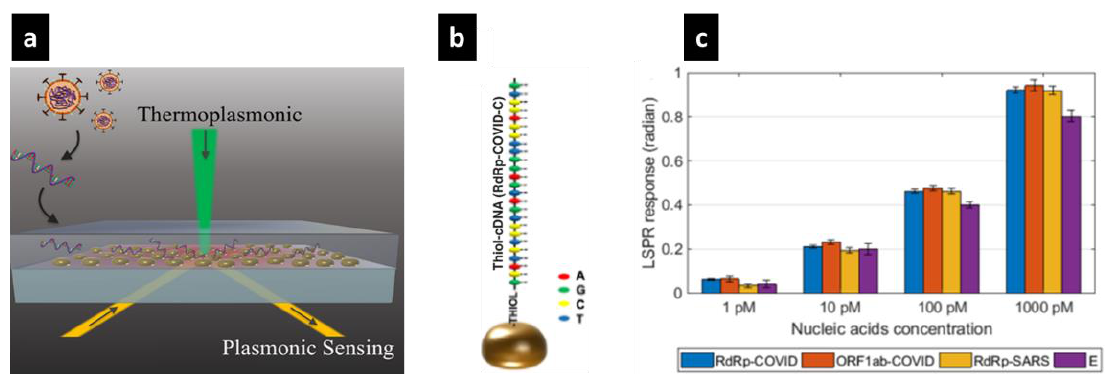
Figure 11. ( a ) Schematic diagram of a plasmonic biosensor. ( b ) Schematic illustration of surface modification of Au nanoisland and the thiol-cDNA ligands. ( c ) Different nucleic acid concentrations measured using the dual-functional LSPR biosensors Reprinted from Qiu et al. [1]. Copyright 2020 American Chemical Society.